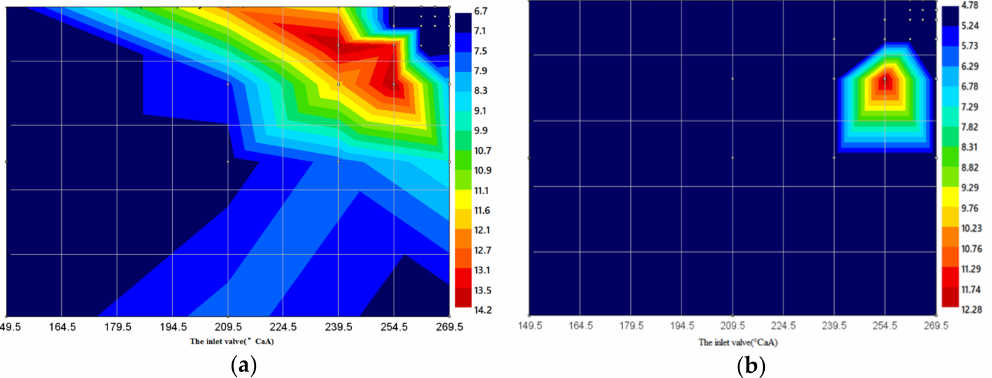
Figure 9. ( a ) B0 and ( b ) B20. Soot emission of different biodiesel ratios under 75% load